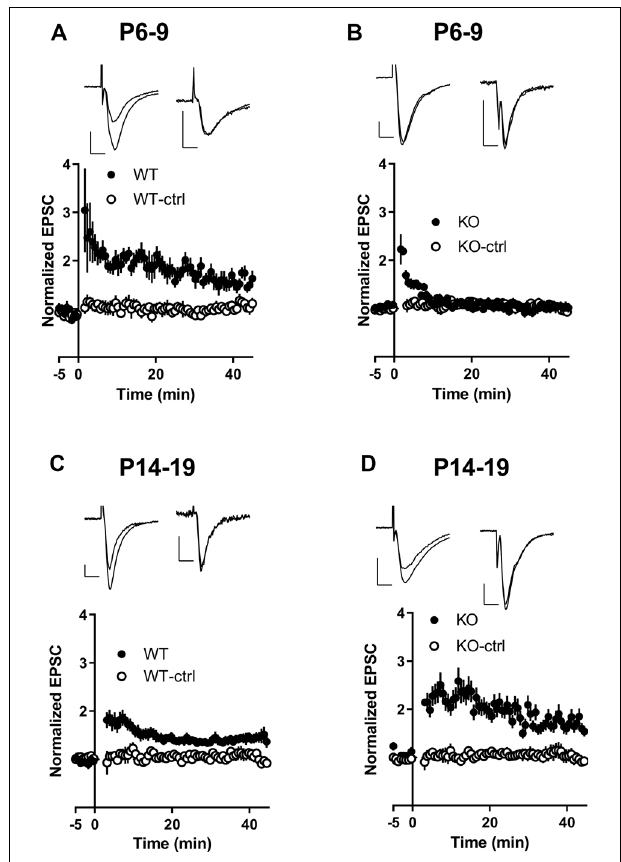
FIGURE 3 | Long-term potentiation (LTP) of Schaffer collateral-CA1 synapses in FMRP KO during early development. (A–D) In the presence of a GABAA inhibitor, after obtaining a 5-min baseline, LTP was induced in CA3-CA1 synapses by stimulation of Schaffer collaterals by stimulating the axons at 3 Hz for 2 min while clamping the cell at 0 mV (black dots). A second stimulation electrode was used as a control (white dots). This protocol readily induced LTP in WT P6–9 slices ( A ; n = 8) and P14–19 slices ( C ; n = 13). (B,D) LTP induction in KO slices P6–9 ( B ; n = 12) and KO slices P14–19 ( D ; n = 7). Insets are examples of evoked EPSCs from the baseline period and 40 min after LTP induction. The left pair of traces are from the test path and the right are from the control path. Scale bars 10 ms and 50